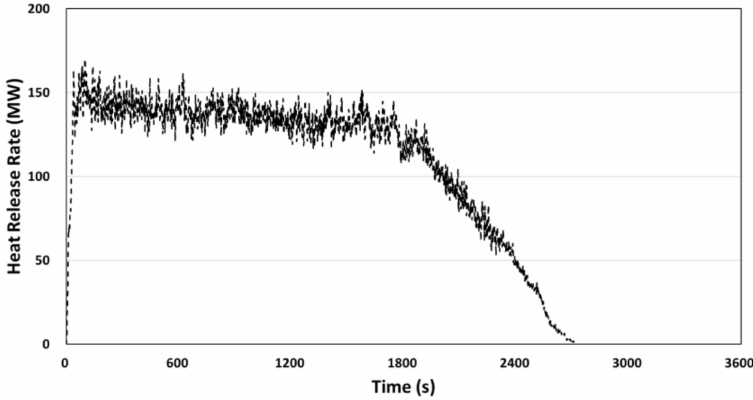
Figure 6. Fire intensity based on vehicle fire analysis.